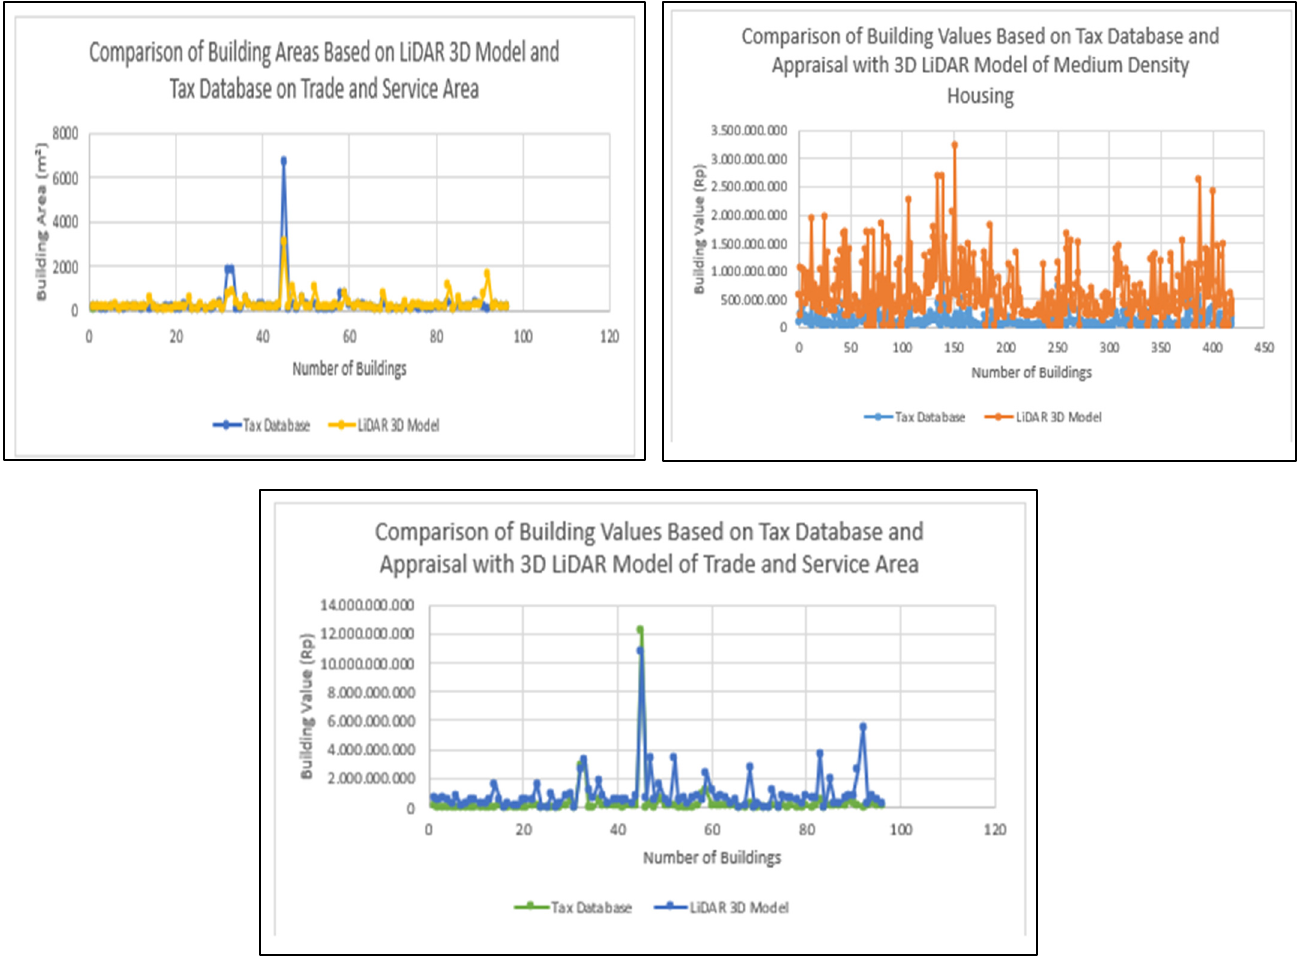
Figure 9. Comparison Graph of Building Values Based on NJOP (source: data processing documen- tation) .